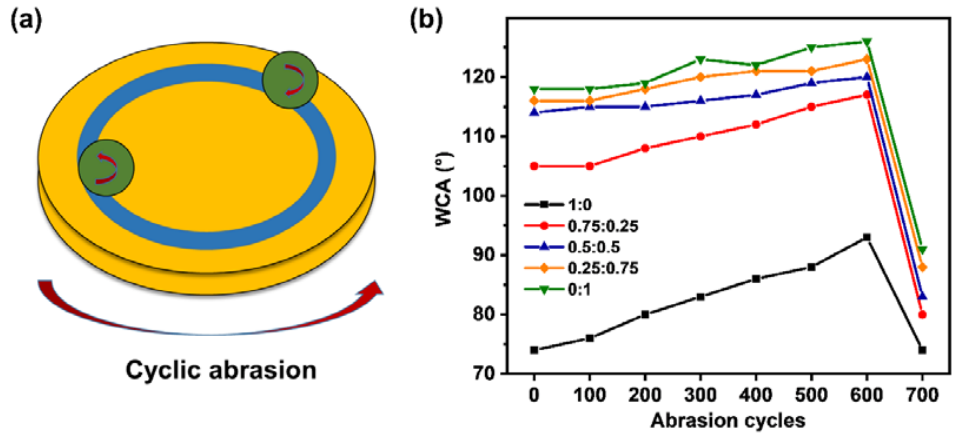
Figure 4. ( a ) Schematic illustration of abrasion test on a leather and ( b ) WCA change on the coated leather after repeated abrasion.